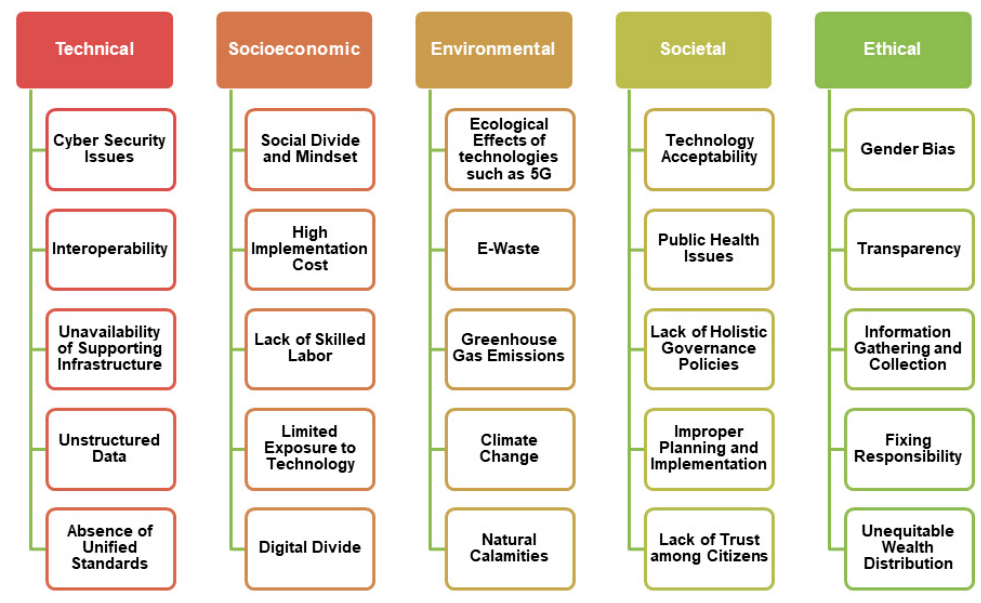
Figure 7. Issues and Challenges in Smart City Development.